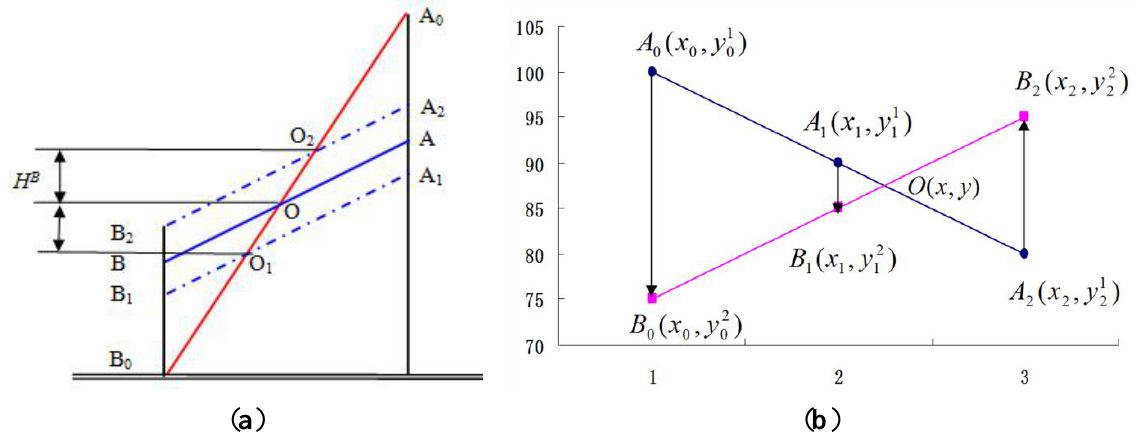
Figure 2. ( a ) Schematic diagram of the automatic search process for the balance line in a slice through a landslide. The red line represents the pre-landslide surface profile; the blue solid line represents the real whereas the dotted lines represent the post-landslide slope profile generated by the DTMs; ( b ) Schematic diagram of the program termination condition for